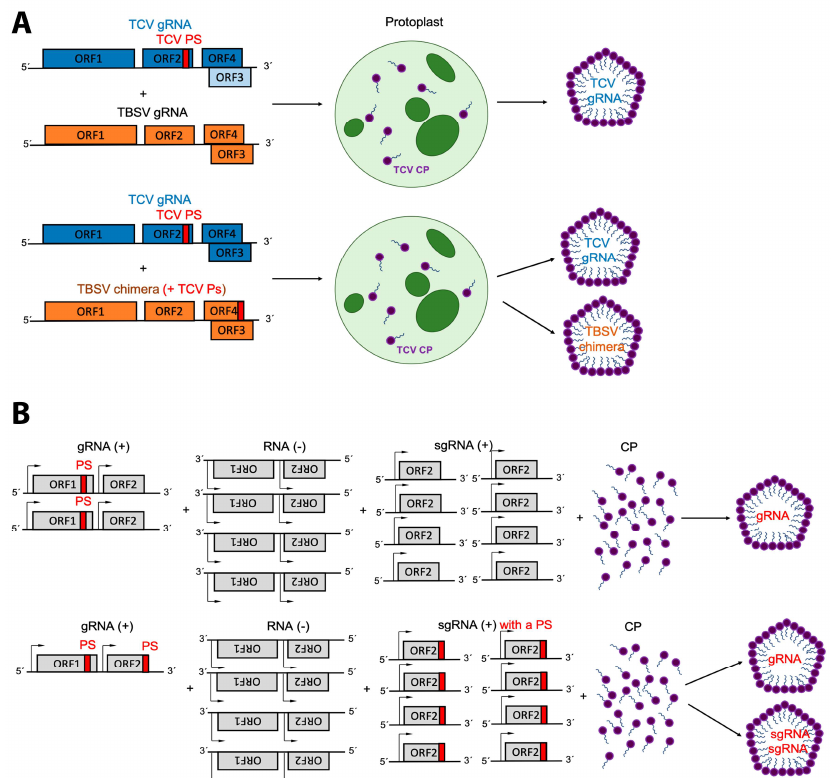
Figure 2. RNA replication for (+)ssRNA viruses and PS-mediated packaging. ( A ) Insertion of turnip crinkle virus (TCV) PS into tomato bushy stunt virus (TBSV) gRNA is sufficient for TCV capsid protein to package the TBSV RNA in protoplast and in the presence of the wild-type TCV gRNA. ( B ) In viruses such as Togaviruses, the sgRNA and the ( − )ssRNA, which are in excess with respect to the gRNA, are not packaged. This is most commonly attributed to presence of a PS. For example, insertion of the Venezuelan equine encephalitis PS in its sgRNA is sufficient to package this RNA molecule. ORF refers to open reading